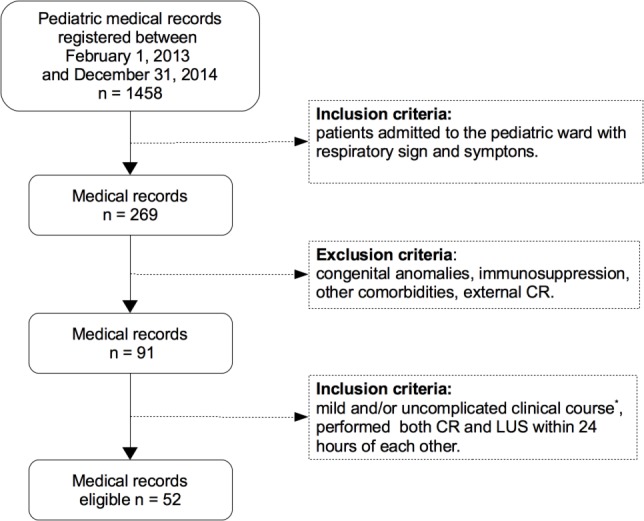
Flowchart medical records selection.∗ Mild disease: Nil or mild increase in effort to breathe, temperature <38.5 °C, respiratory rate <50 breaths/min, mild recession or breathlessness, taking full feeds, no vomiting, oxygen saturation ≥95% in room air according to the criteria of the British Thoracic Society guidelines (Harris et al., 2011). CR, chest radiography; LUS, lung ultrasound.